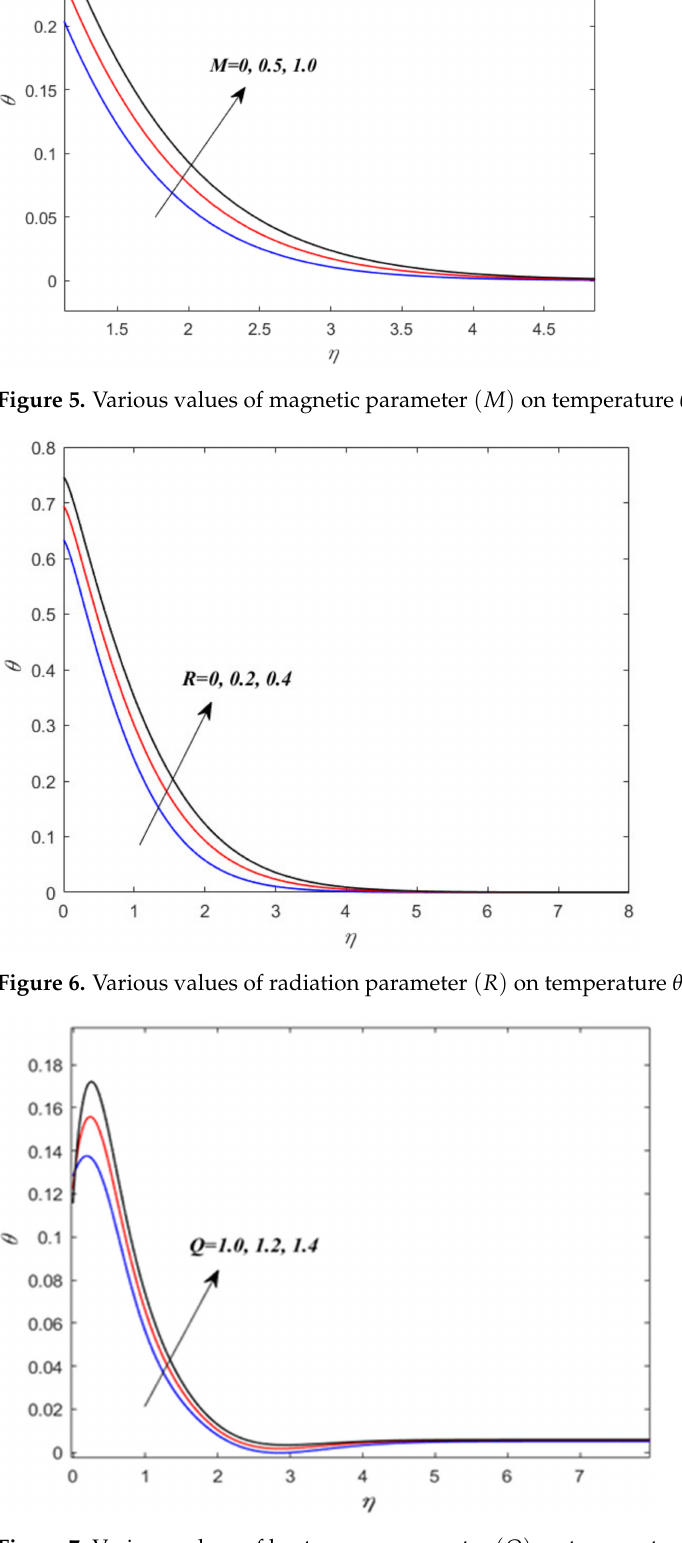
Figure 7. Various values of heat source parameter ( Q ) on temperature θ ( η )